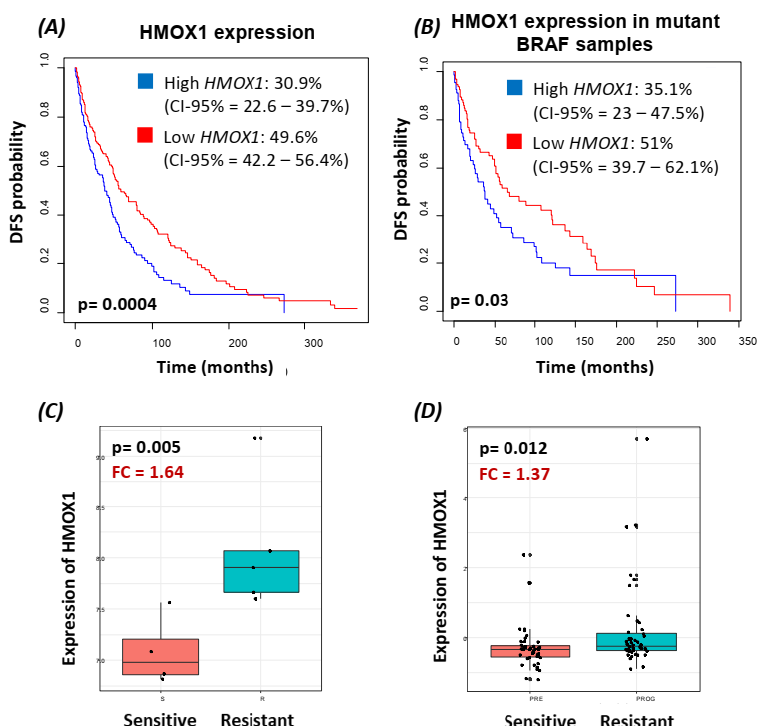
Figure 2. Transcriptomic analysis on public datasets highlighted the role of HMOX-1 in aggressiveness and BRAF inhibitor resistance in melanoma. ( A , B ) Kaplan–Meier curves representing the disease-free survival (DFS) of patients with a high expression of HMOX-1 compared to samples with low expression of HMOX-1 in a TCGA melanoma cohort (406 samples with survival information) ( A ) and in BRAF mutant samples (165 samples) ( B ) HMOX-1 expression was stratified as “high” and “low” with an optimized cut-off. ( C ) Boxplot representing the distribution of HMOX-1 expression in sensitive and resistant mice after A375 cell inoculation and BRAF inhibitor treatment (GSE74729, 4 sensitive and 5 resistant samples). ( D ) Boxplot representing the distribution of HMOX-1 expression in sensitive and resistant patients in a merge of 3 melanoma patient datasets (43 BRAF inhibitor sensitive (before treatment) and 48 resistant and relapse of disease (after treatment)). FC, fold change; DFS, disease-free survival.